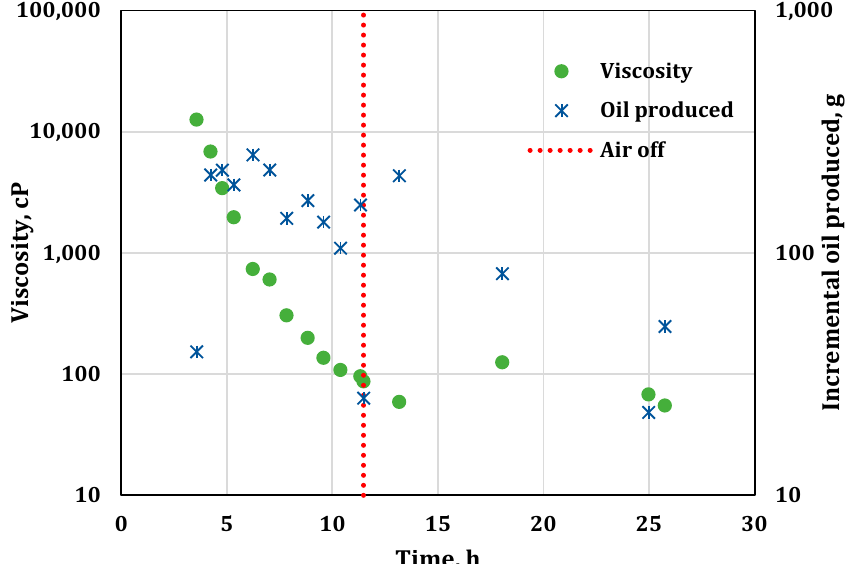
Figure 18. Viscosity of the produced oil. In Figure 19, a continuous upgrade of the API gravity and viscosity (measured at 25 °C), along with the asphaltene content reduction, can be observed. The results of the simulated distillation percent, showing the split between distillate (400°C- fraction) and residue (400°C+ fraction), confirm the upgrading of the produced oil samples. The extraction of the core samples started from the production end. Core 1 and Core 2 correspond to the sample located at the production end, representing frac sand with the meshes of 16 and 20/30, respectively. As expected, the hydrocarbons remaining in the core exhibited a higher asphaltene content because the original oil-heavy components precipi- tated onto the surface of the mineral skeleton. The highest accumulation of asphaltenes was observed in areas beyond the point where the air injection stopped (corresponding to the collected sample Core 8), where a coke-like wall was evident.